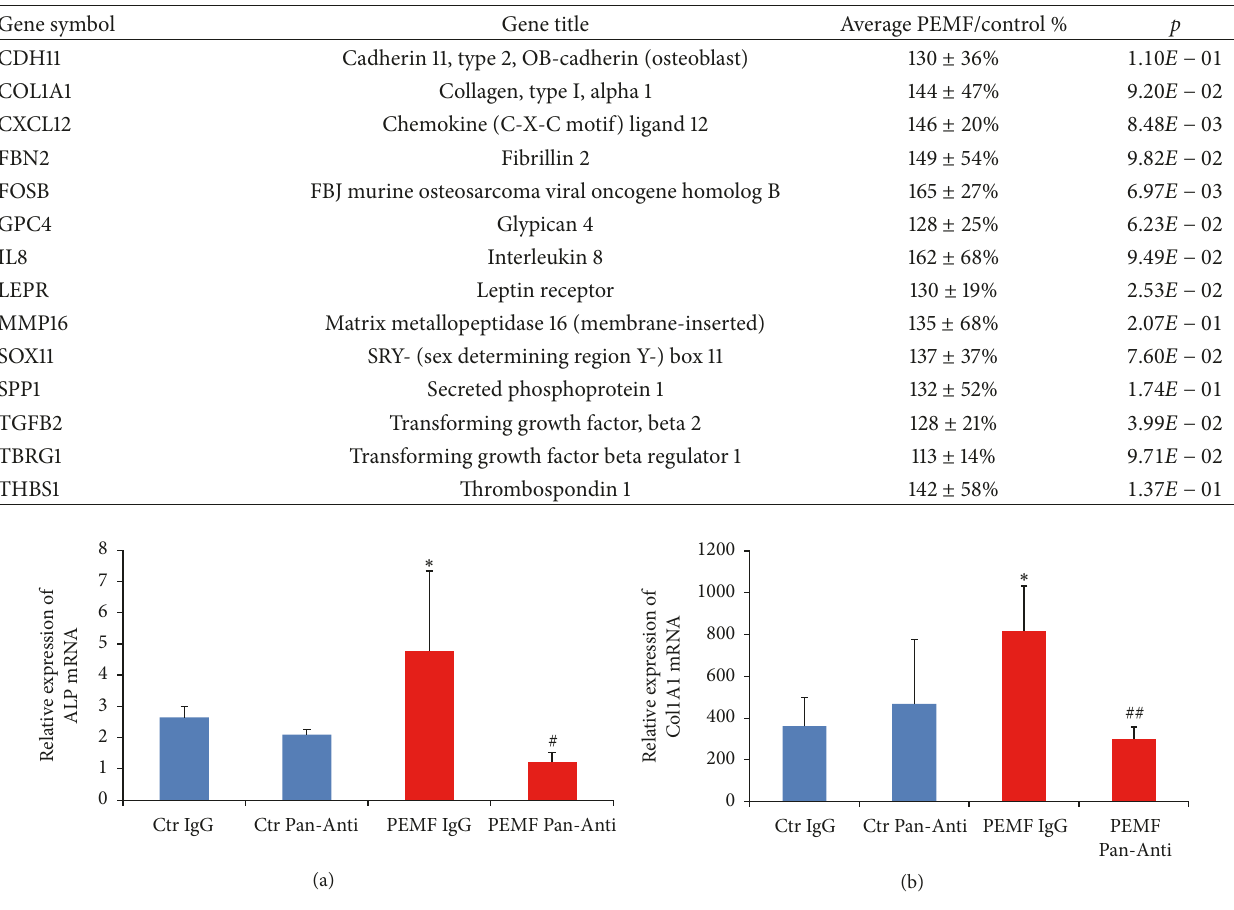
Table 6: Real-time RT-PCR analysis of three different female donor samples’ hBMSCs, aged 24, 27, and 31 years in the mineralization stage. Analysis by Student’s 𝑡 -test.